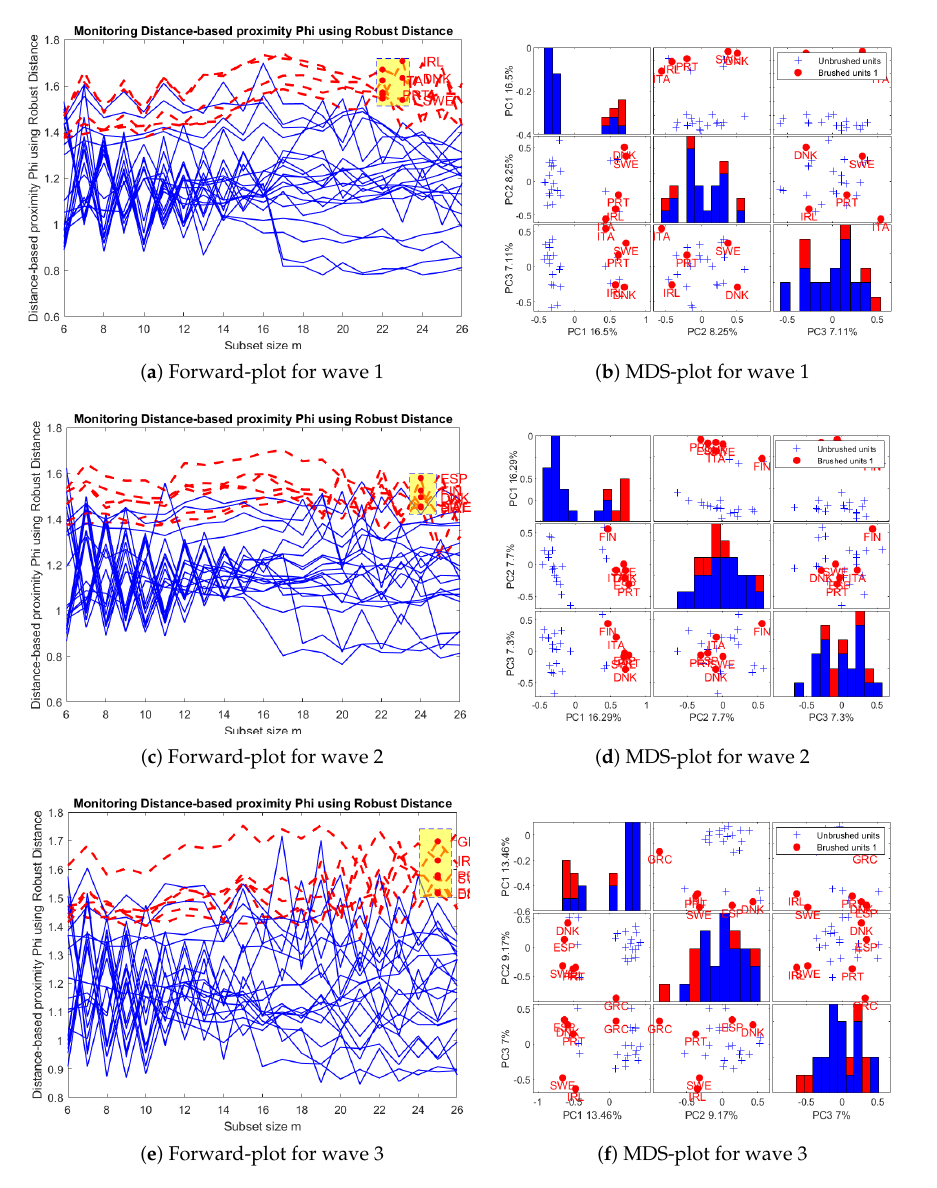
Figure 7. Visualization step: Graphical output of the FS-DB algorithm for waves 1 to 3. The Forward-plots monitor the trajectories of the units in order to illustrate their performance along the steps of the FS-DB algorithm. In the first step of the algorithm the subset of closest units is identified (according to a proximity function based on distance δ